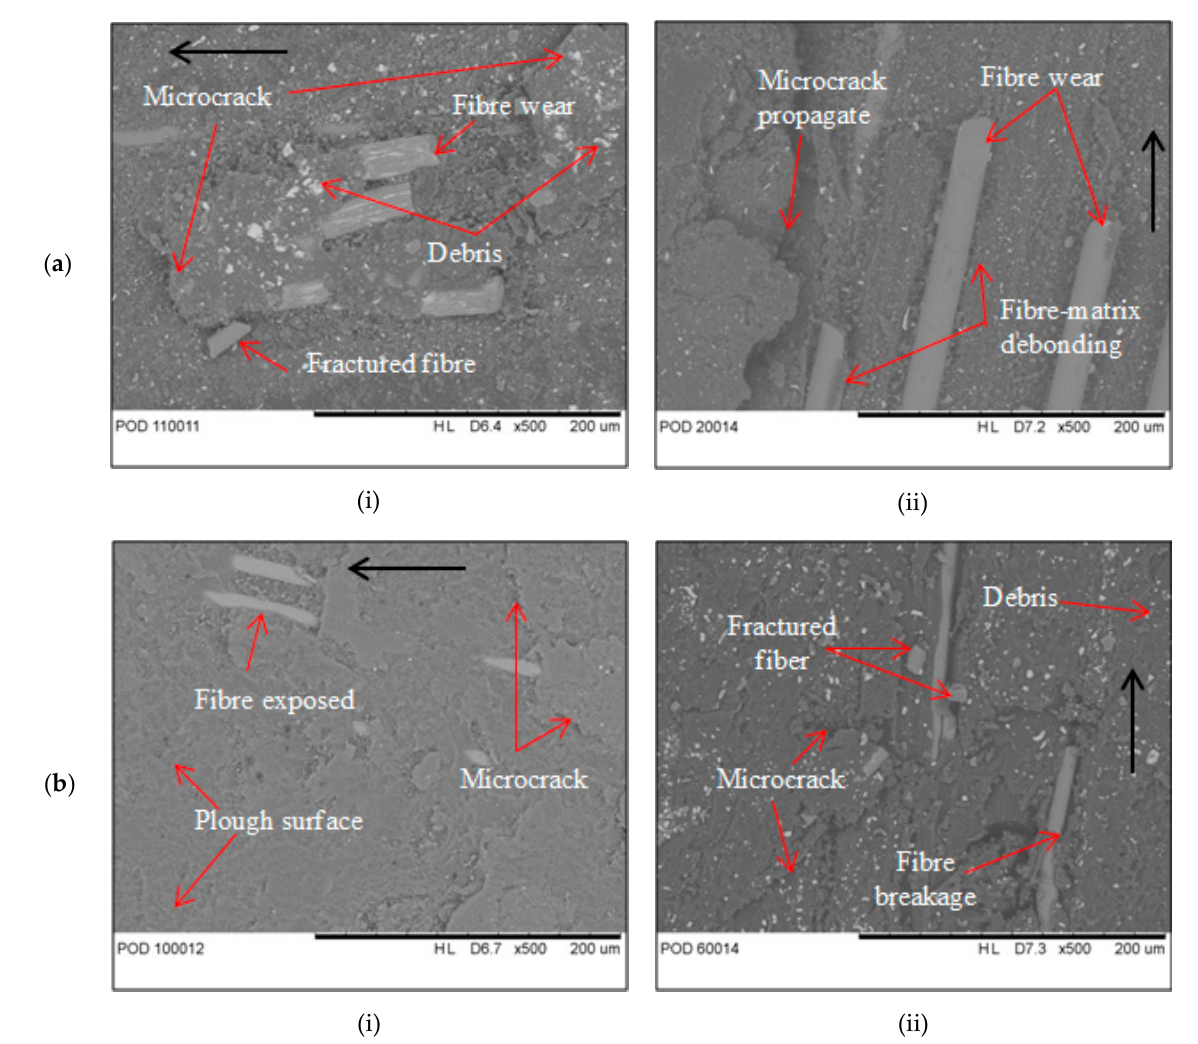
Figure 6. SEM micrograph of worn surface of ( a ) EP/GF and ( b ) EP/BF composites at (i) 0. 23 MPa.m/s and (ii) 0. 93 MPa.m/s PV factor.